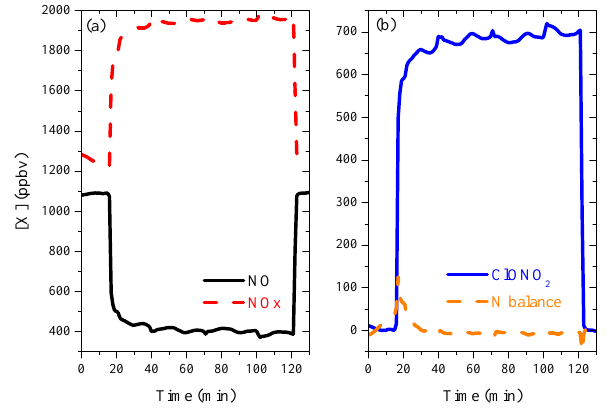
Figure 2. Response of measured NO and NO x mixing ratios to the introduction of ClONO 2 into the flow tube (left panel). The corre- sponding calculated ClONO 2 mixing ratio and nitrogen balance are also shown (right